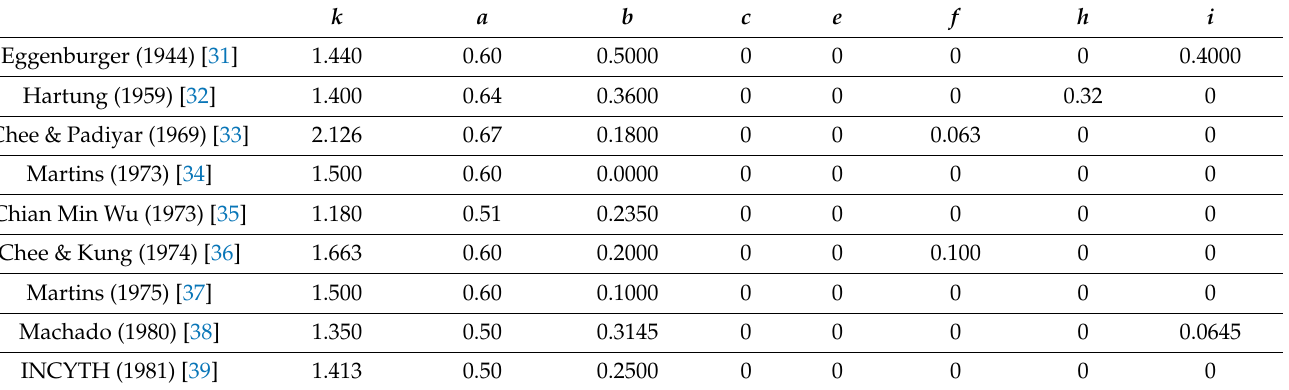
Table 2. Coefficient adopted for the calculation of the scour with